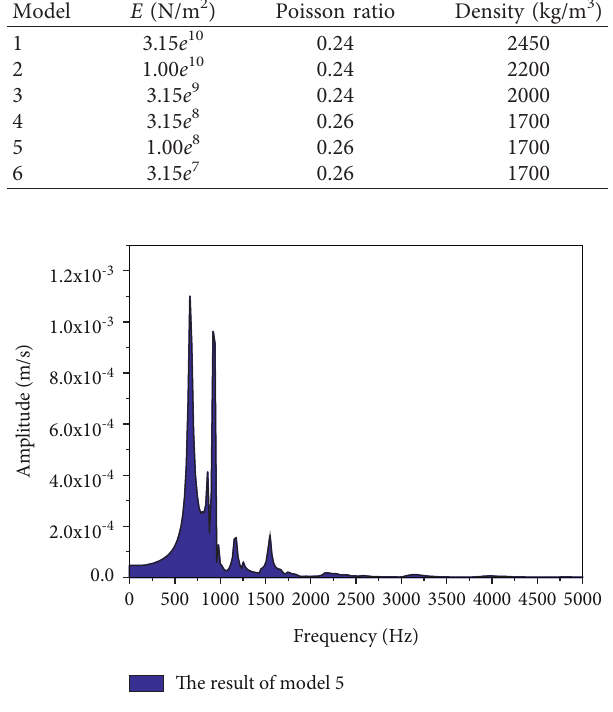
Figure 16: Waveform spectrum with floating